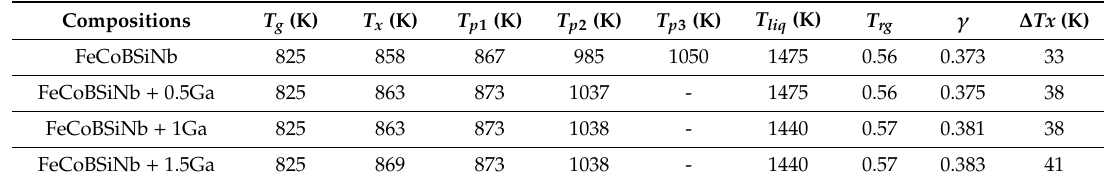
Table 1. Thermal stability parameters T g , T x , T p 1 , T p 2 , T p 3 , T liq , T rg , γ and ∆ T x as a function of